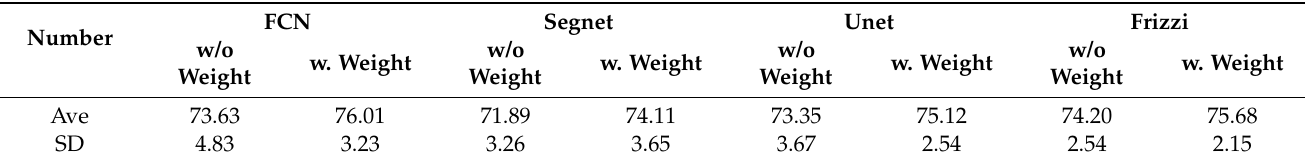
Table 6. Comparison of different segmentation methods with and without